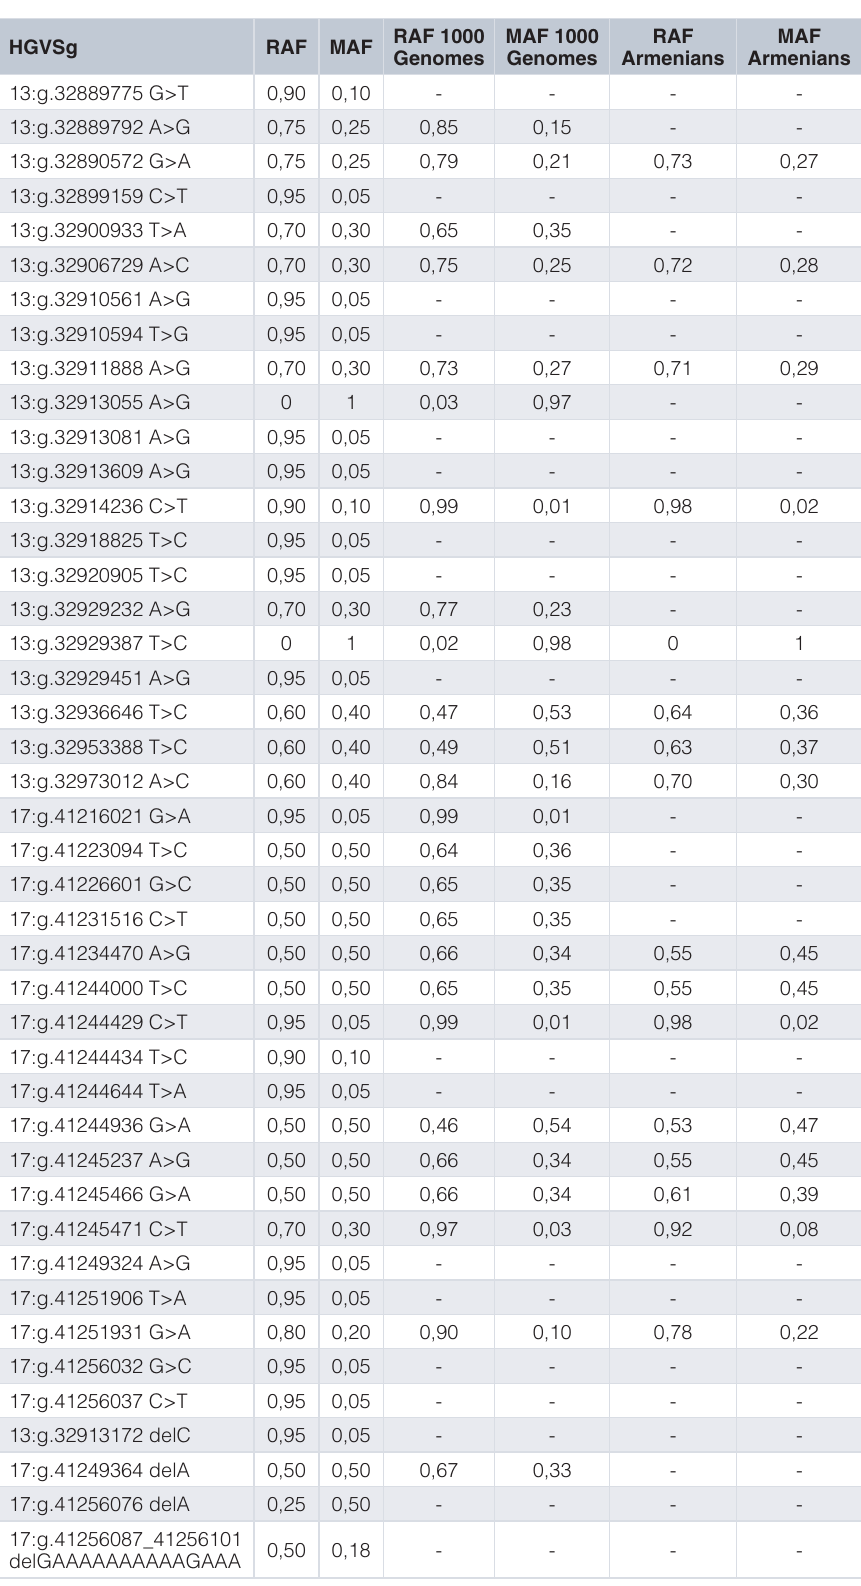
Table 4. Distribution of identified variants in healthy Armenians and in 1000 genomes populations. The frequency distributions of identified mutations in the study group were compared with data from 1000 Genomes population, as well as the genome-wide association study from 54 healthy Armenian females 20 .